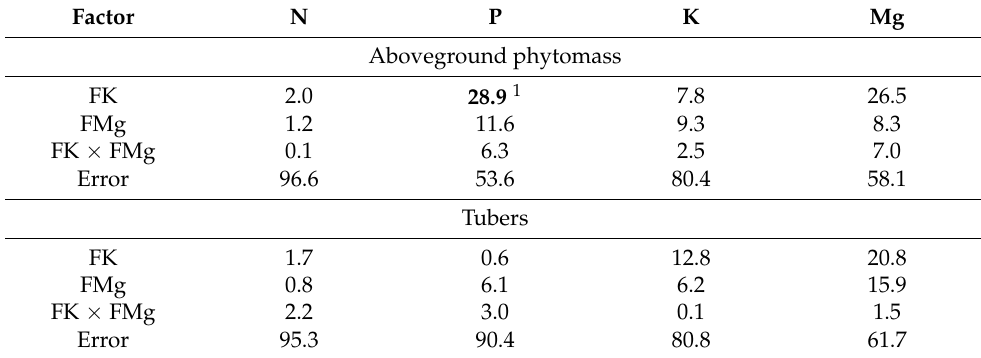
Table 5. ANOVA results: factor contribution (%) to the total variance of potato aboveground phy- tomass and tubers in the microplot field experiment with potassium (FK) and magnesium fertili- zation (FMg).